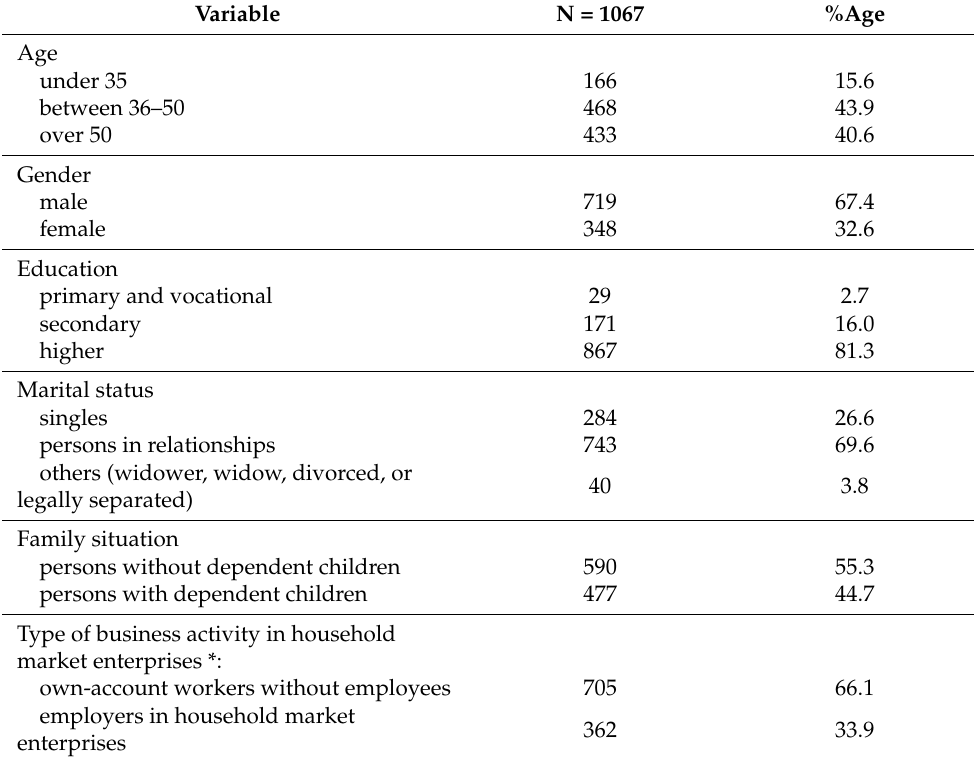
Table 1. Responses: descriptive